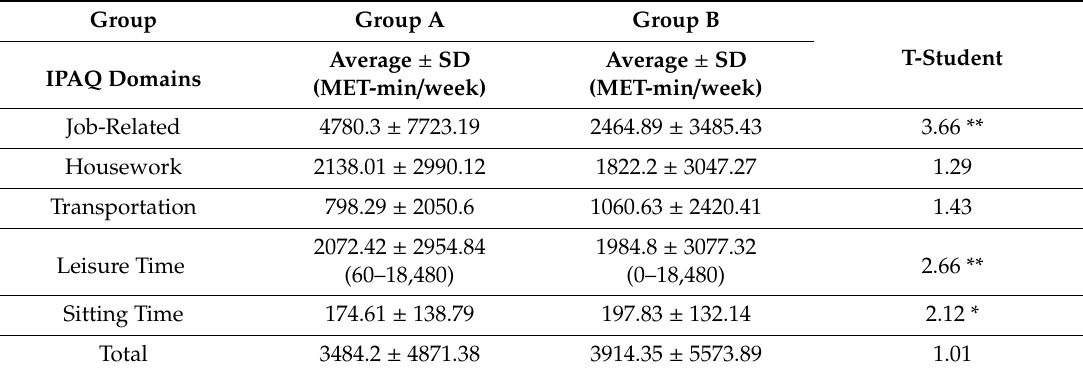
Table 2. The level of physical activity of women in particular areas according to IPAQ.